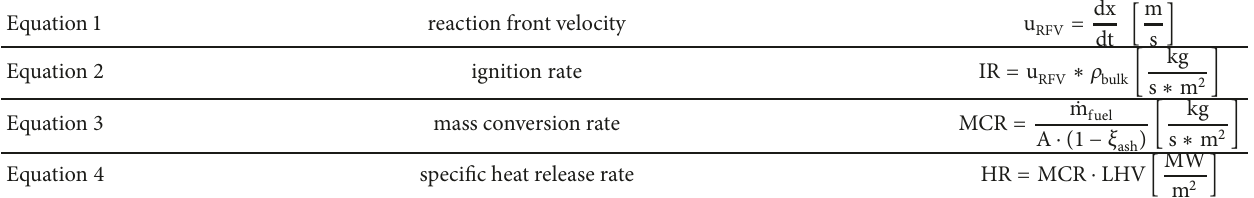
Table 1: Overview of the characteristic numbers [11].